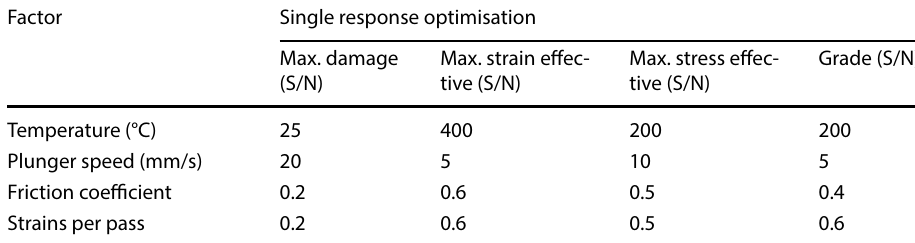
Table 7 Optimum conditions for the MDF process as per the signal to noise